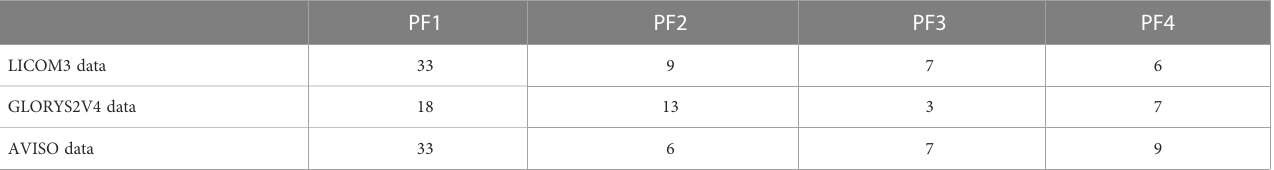
TABLE 1 The numbers of eddies with the largest value of b occurring in PF1, PF2, PF3, and PF4, respectively. PF1